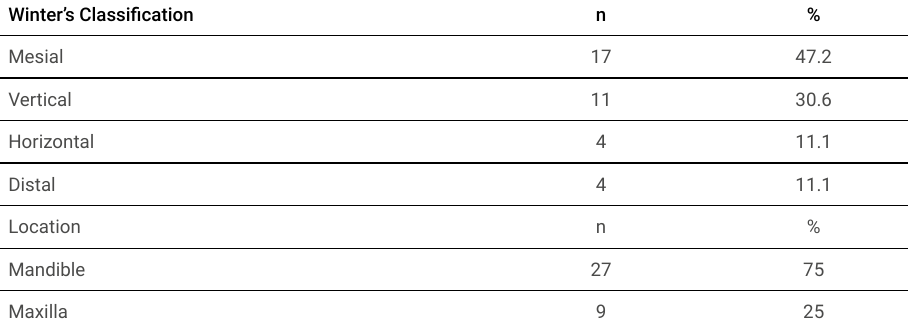
Table 1. Distribution of groups according to the Winter’s classification and anatomical location.